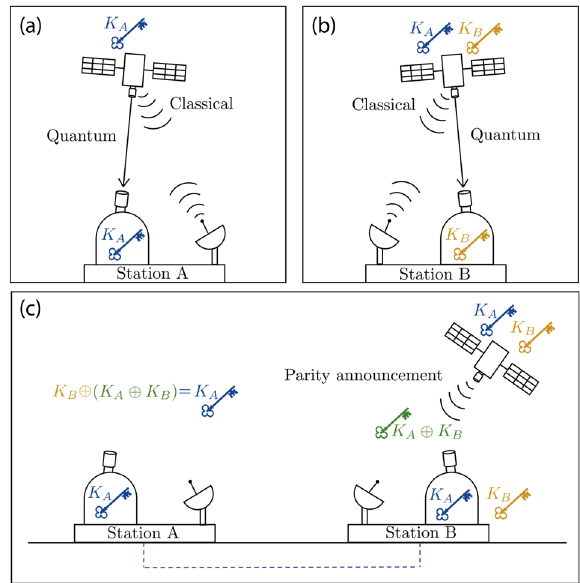
Fig. 1 Illustration of the most common satellite QKD scheme: the fl ying trusted-node. In step a , the satellite establishes a shared secret key K A with station A by running a QKD protocol, which requires both classical and quantum communication. This step is repeated in b to establish a shared secret key K B , this time with station B located further away. At the end of these steps, the satellite holds both keys, while each station knows only their own. Finally, in step c , the satellite publicly announces the parity of both keys K A ⊕ K B . This allows station B to determine key K A , which can then be used to encrypt private communications to A and vice